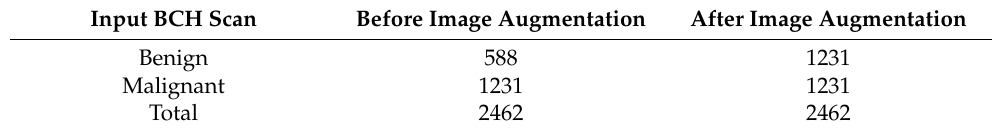
Table 2. Input BCH scan for the two classes.